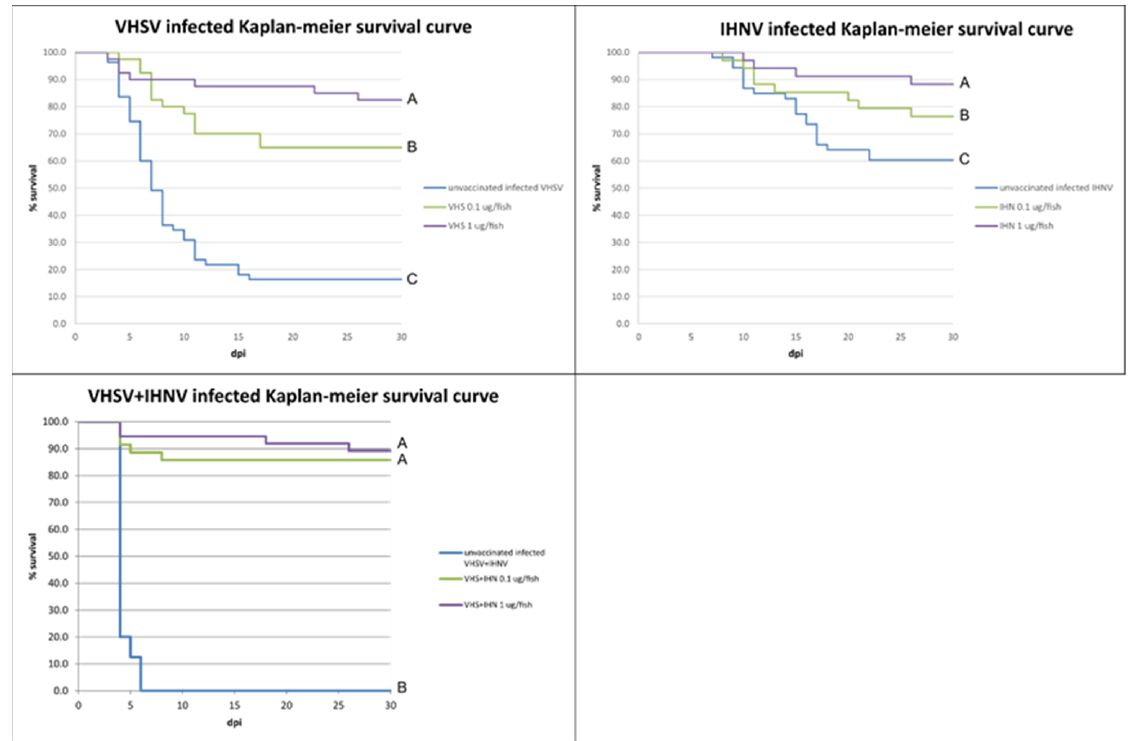
Figure 4. Controlled conditions potency test results. Kaplan–Meier survival curve for each challenged group, comparing mock vaccinated group with vaccinated groups. Different letters indicate statistical differences in pair-wise comparison ( p < 0.01).